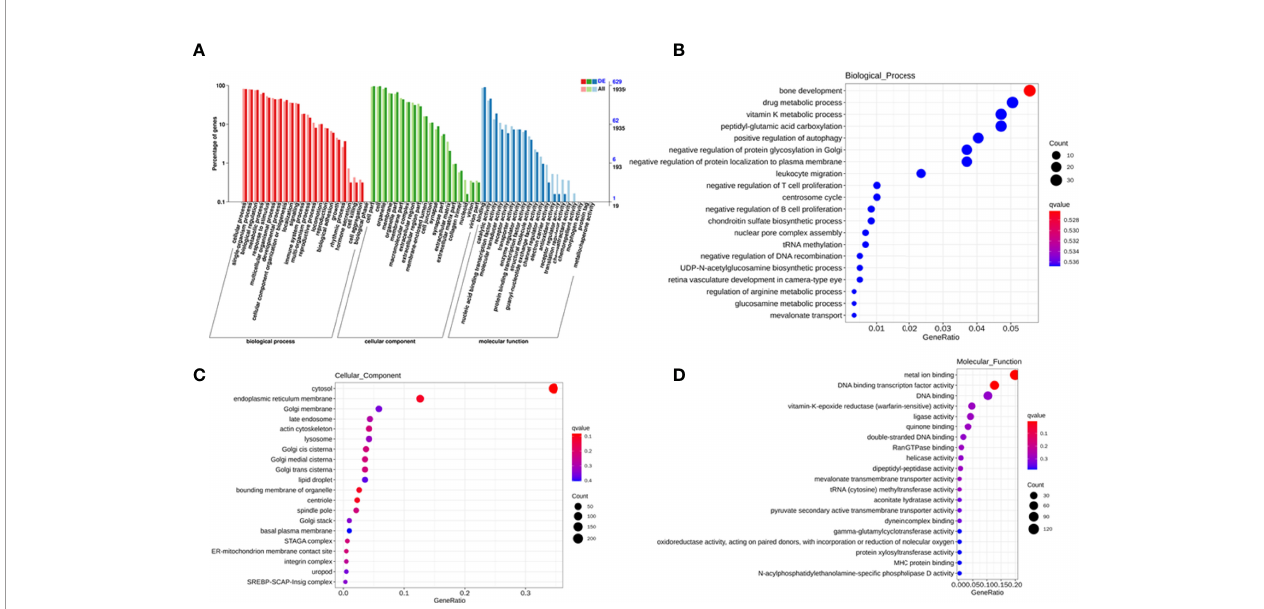
FIGURE 5 | GO terms of trans-acting genes of differentially expressed exosomal lncRNAs. GO categories of differentially expressed lncRNAs (A) . Top 20 signi fi cant enriched biological processes (B) , cellular components (C) , and molecular functions (D) of differentially expressed lncRNAs.